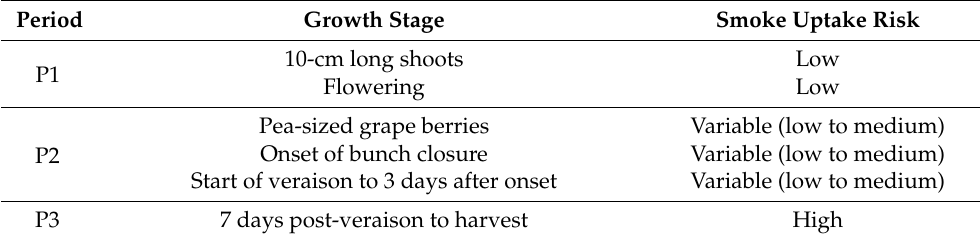
Table 3. Grapevine growth stage and the sensitivity to smoke exposure